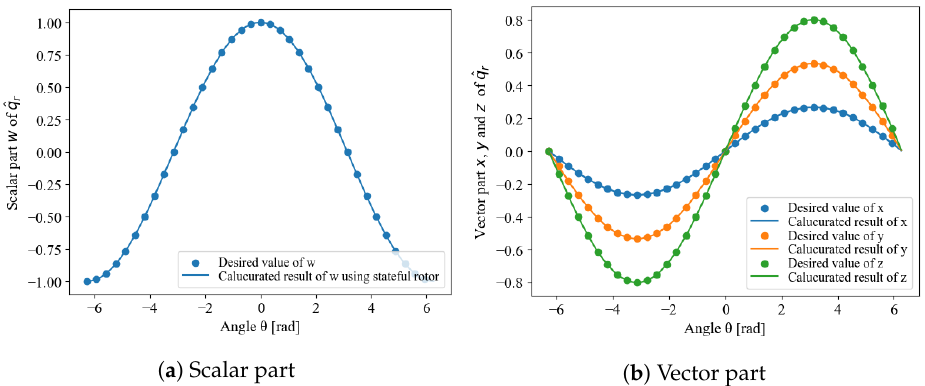
Figure 3. Continuity and uniqueness of stateful rotor when the initial state ˆ q r ,0 is close to q r ,1 .